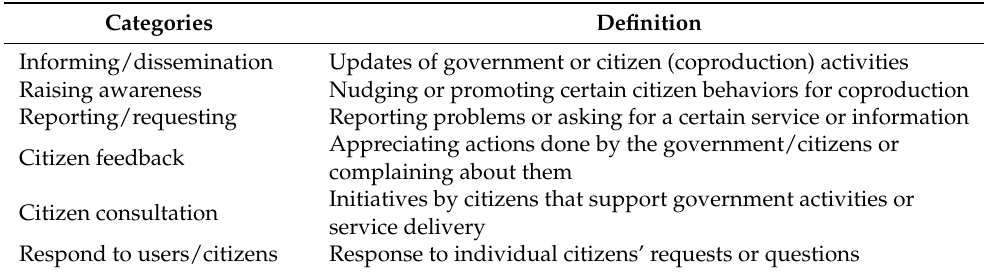
Table 1. Definitions of categories (results of open